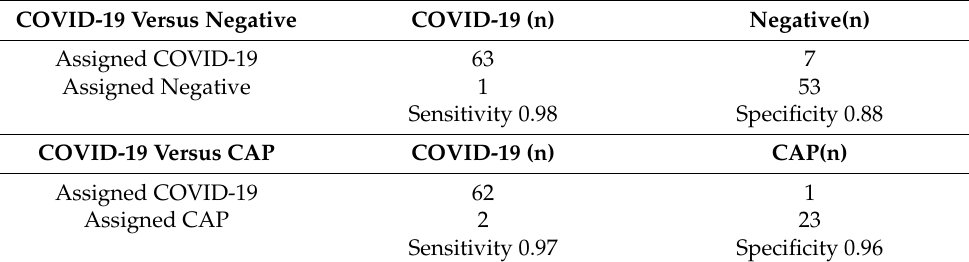
Table 3. Independent testing I performance of the proposed AI system. COVID-19 Versus